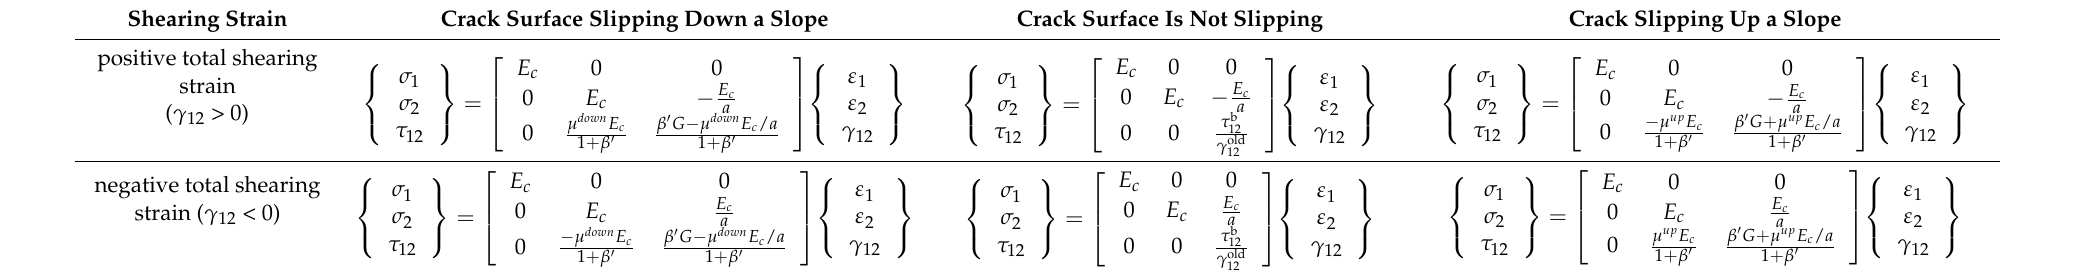
Table 4. Secant stiffness matrices at crack direction 2